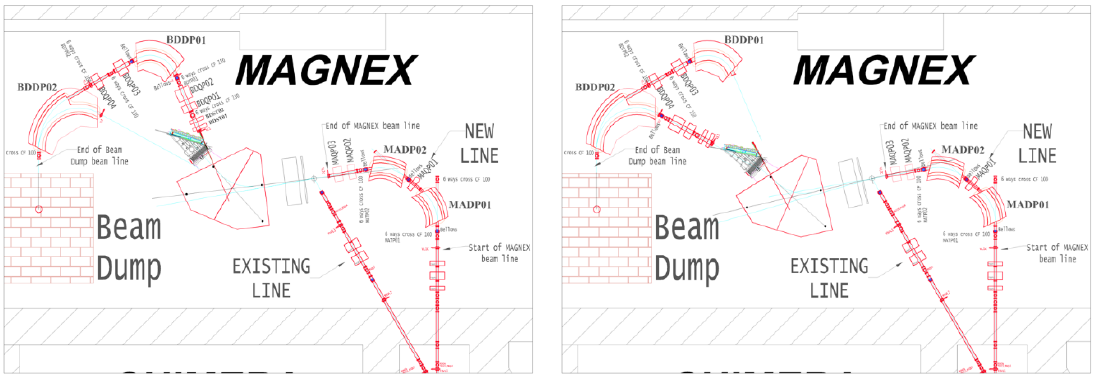
Figure 6. The two figures show the different MAGNEX positions, on the left the − 3 ◦ position and on the right the +3 ◦ position with respect to the new MAGNEX beam line. In the main layout of the new MAGNEX experimental area, the wall on the left side will be moved by about 4.5 m to allow the installation of the large beam dump. The MAGNEX spectrometer will be rotated by 70 ◦ with respect to its actual 0 ◦ position to allow the transport of the beam coming from the spectrometer to be transported to the beam dump. A new line is necessary to deliver the beam to the MAGNEX at the new